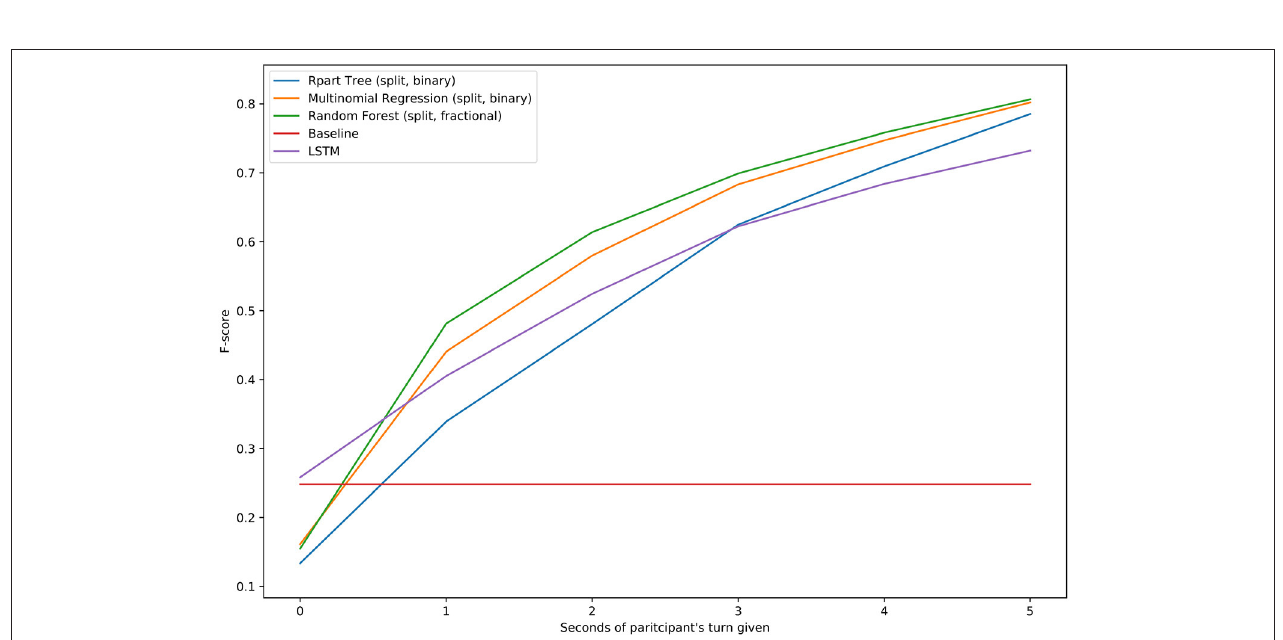
FIGURE 7 | F-score (blue, the left bar of each pair) and accuracy (orange, the right bar of each pair) when training a random forest model on split, fractional data. For each of the 28 models, one individual is left out as test data—this is the individual pointed out on the X axis label. The rest of the dataset is used as training data. This figure thus shows how certain individuals use behaviours that are harder to interpret based on training on the behaviours of the other individuals.